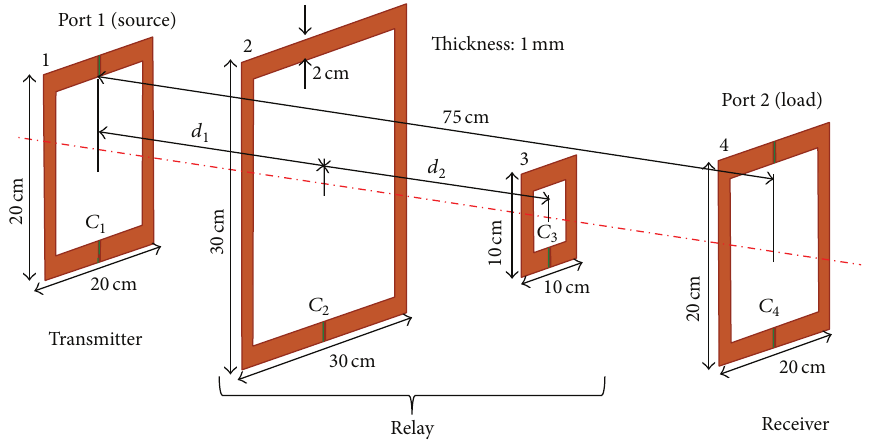
Figure 1: Structure of the asymmetrical relay resonators.